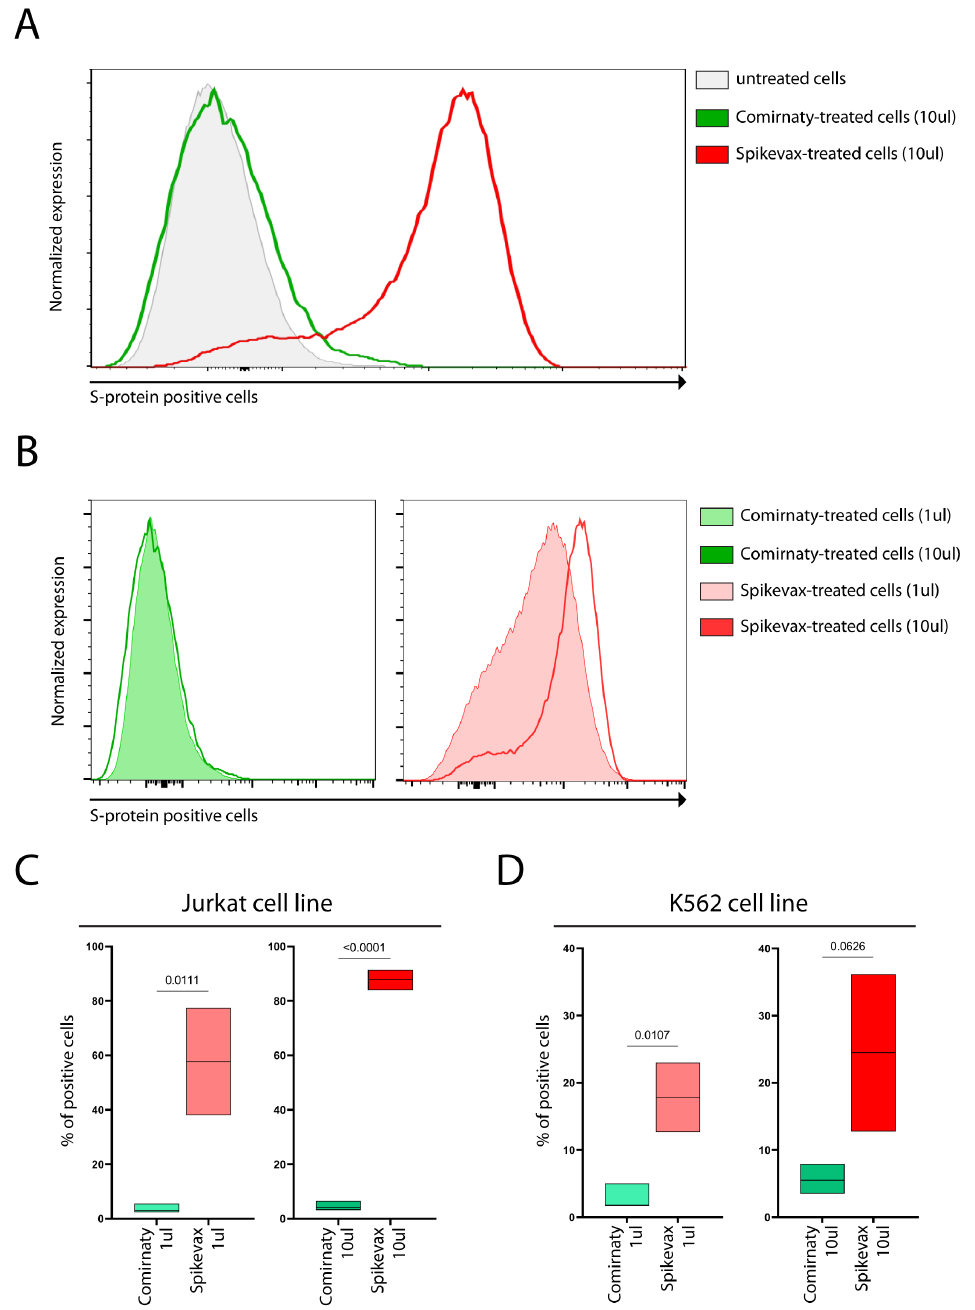
Figure 1. Flow cytometric SARS-CoV-2 Spike protein detection following treatment of cell lines with mRNA-based COVID-19 vaccines. Panel ( A ) shows the results of the flow cytometric evaluation of S-protein-positive cells in 10 µ L Comirnaty-treated (green), 10 µ L Spikevax-treated (red), and untreated (light gray) Jurkat cells (representative experiment). Panel ( B ) shows the flow cytometric evaluation of S-protein-positive cells in 1 µ L (light green full area) and 10 µ L (dark green) Comirnaty-treated Jurkat cells (left panel), as well as in 1 µ L (light red full area) and 10 µ L (dark red) Spikevax-treated Jurkat cells (right panel) (histograms generated from a representative experiment, the same of Panel ( A )). Panel ( C ) (Jurkat cell line) and panel ( D ) (K562 cell line) show floating bars (min to max) depicting the percentage of S-protein-positive cells following 1 µ L (left) and 10 µ L (right) Comirnaty and Spikevax treatment; the line represents the mean value. The difference between Comirnaty and Spikevax treatment was evaluated using the unpaired t -test, and p -values are shown.